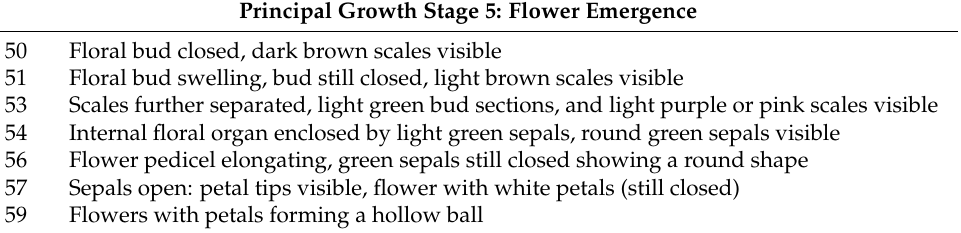
Table 2. Description of the modified BBCH scale for Japanese apricot floral buds from dormancy to